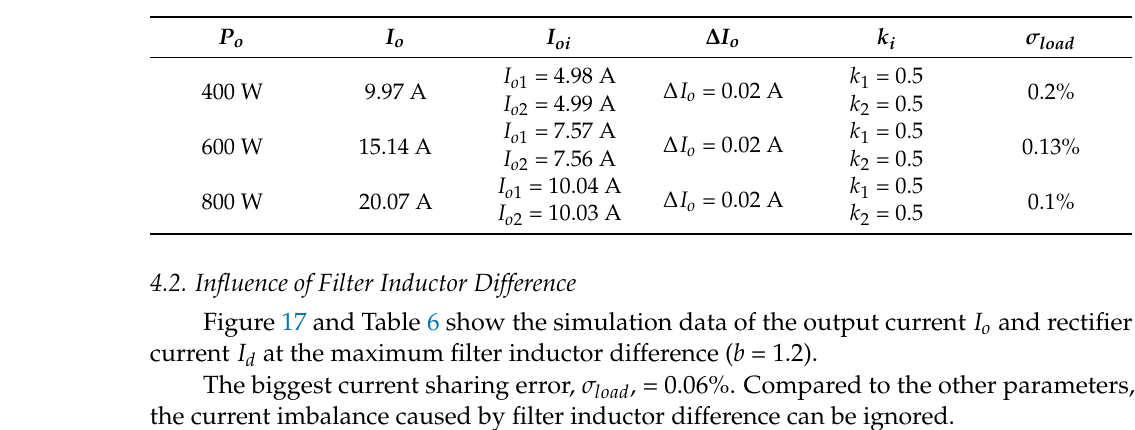
Table 6. Data comparison of different output power when b = 1.2.